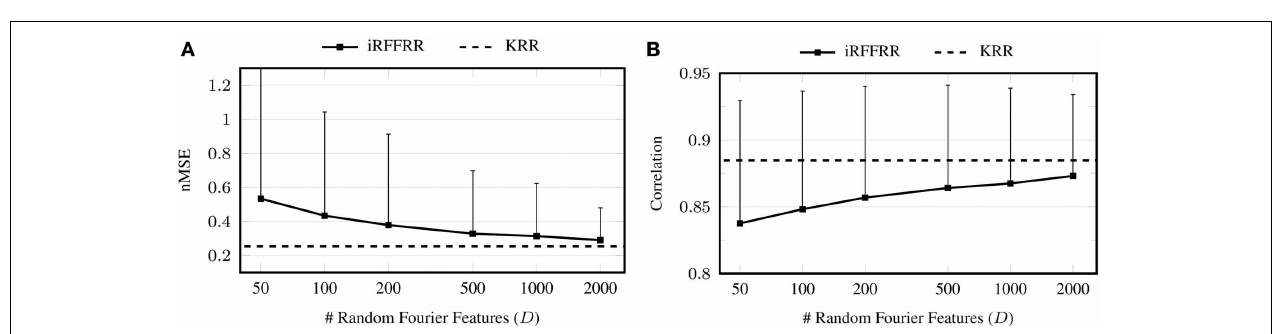
methods are averaged over the ten subjects and the five DOFs. For the iRFFRR method, the results are in addition averaged over 25 runs with different random initializations.